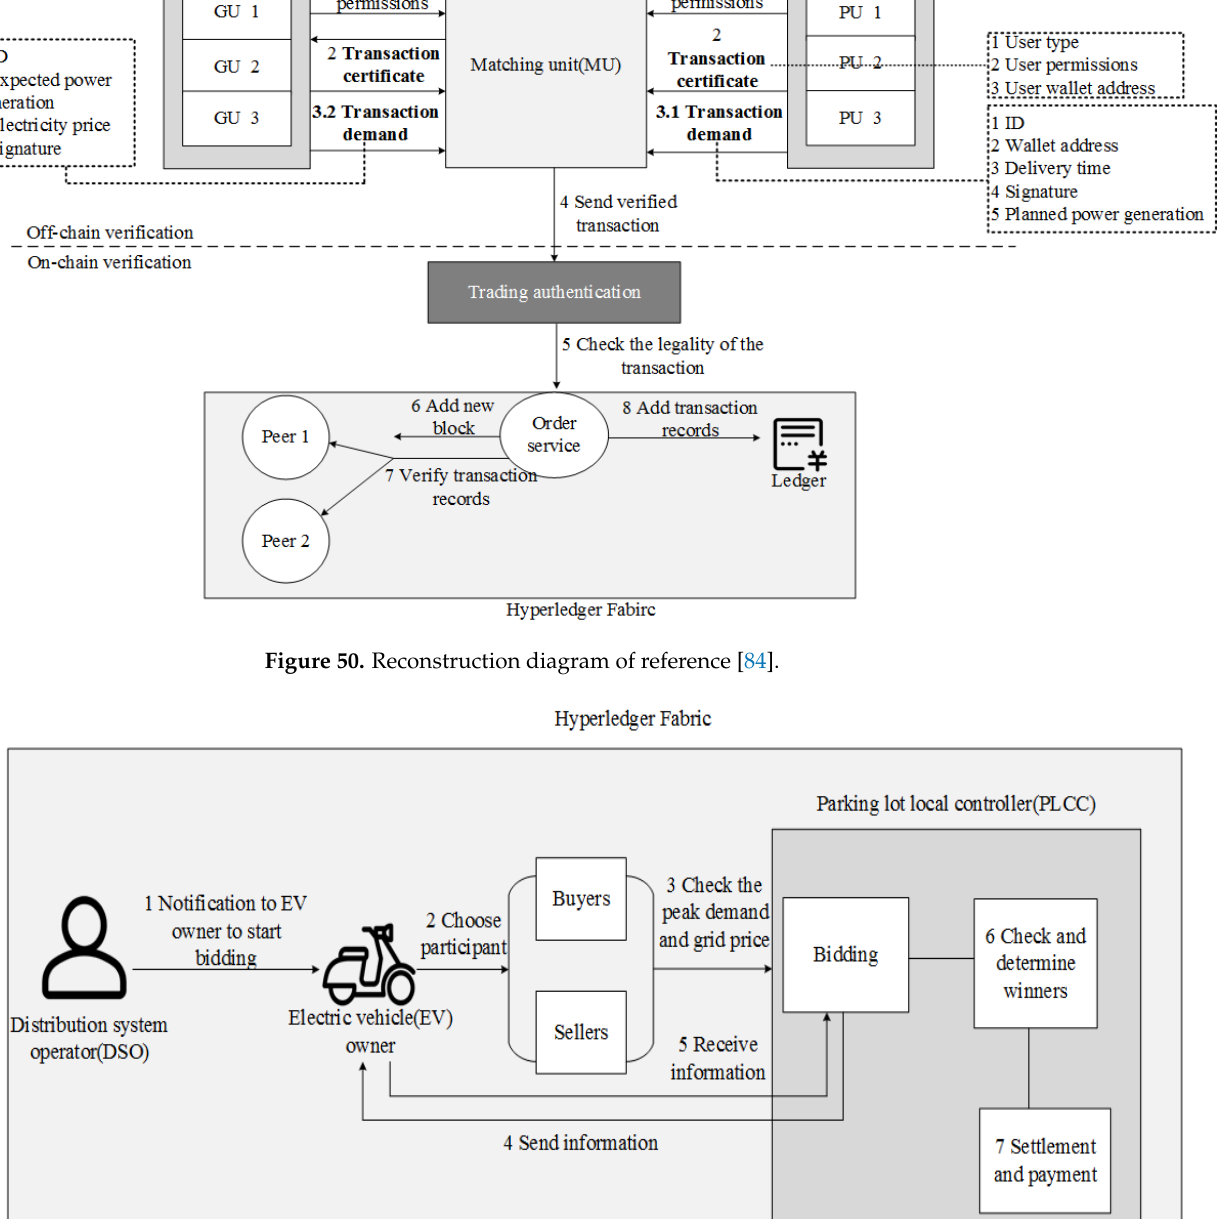
Figure 51. Reconstruction diagram of reference [85].